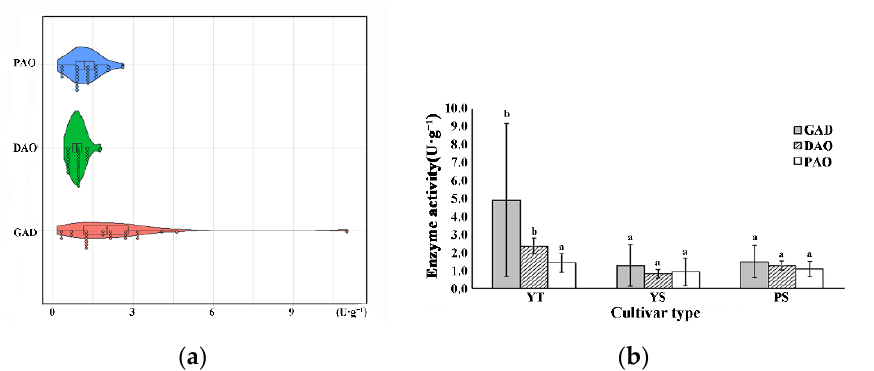
Figure 5. The cultivar variation in GAD, DAO, and PAO activity. ( a ) Cultivar variation in GAD, DAO, and PAO activity; ( b ) The difference of GAD, DAO, and PAO activity among different cultivar types. GAD, glutamate decarboxylase; DAO, diamine oxidase; PAO, polyamine oxidase. Different letters denote significant difference among different highland barley cultivar types at the level p < 0.05.